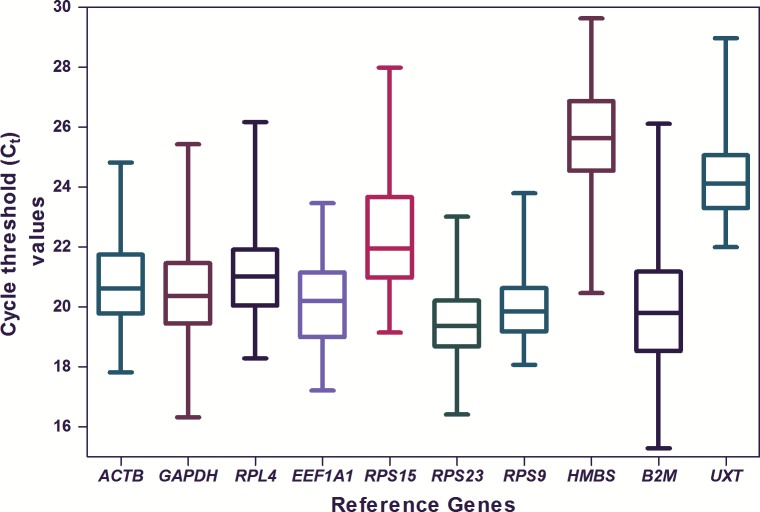
Expression levels of individual candidate RGs.The data is presented as quantification cycle (Cq) values of each gene in the box-whisker diagram. The median is shown as a line across the box while whiskers indicate maximum and minimum values.